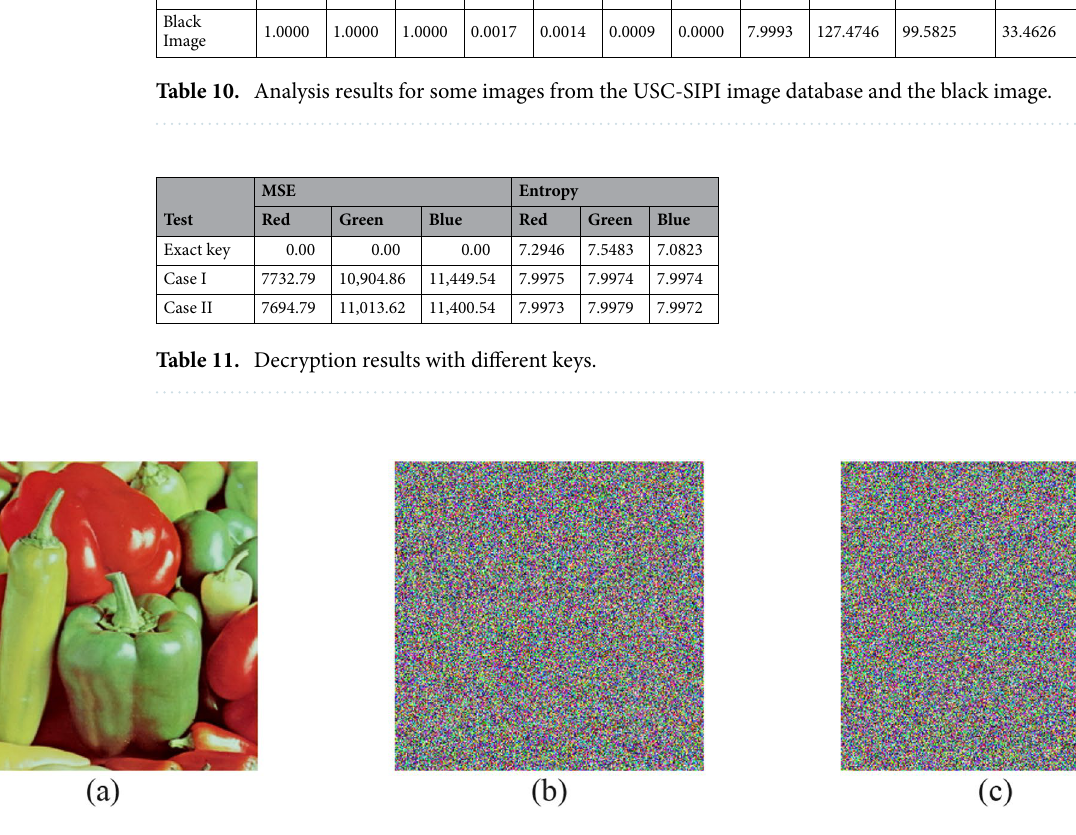
Figure 13. Decryption using ( a ) exact key, ( b ) case I, and ( c ) case II.